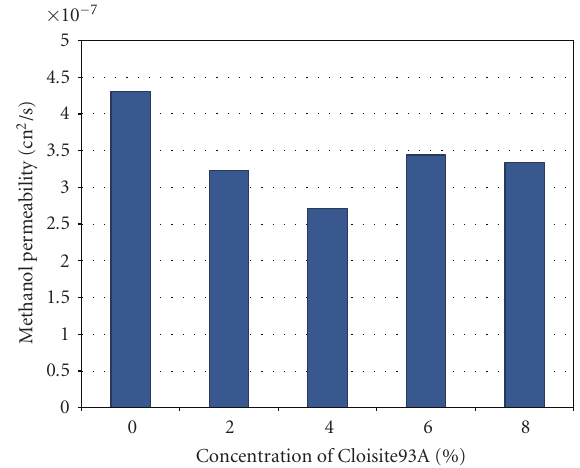
Figure 6: Methanol permeability values of sulfonated PVA mem- branes with varying concentrations of Cloisite 93A.